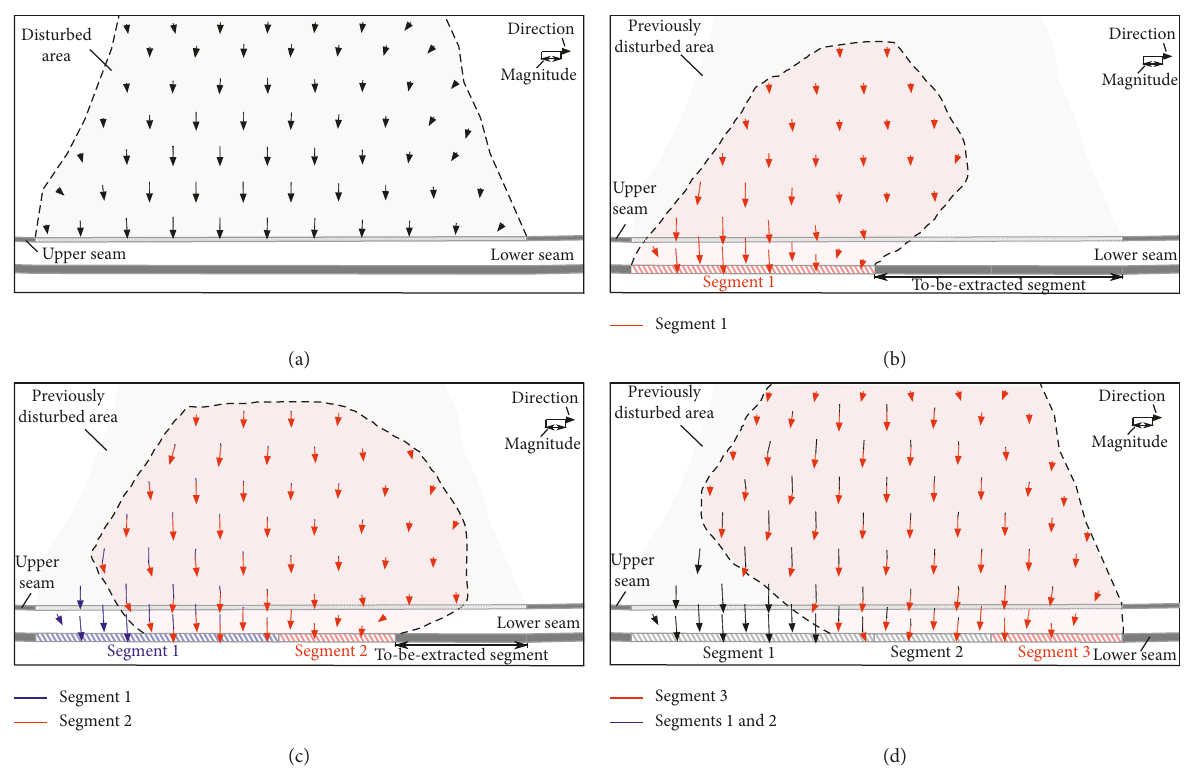
Figure 6: Deformation pattern after extraction of (a) lower panel and (b–d) different segments of the upper panel in Case 1.